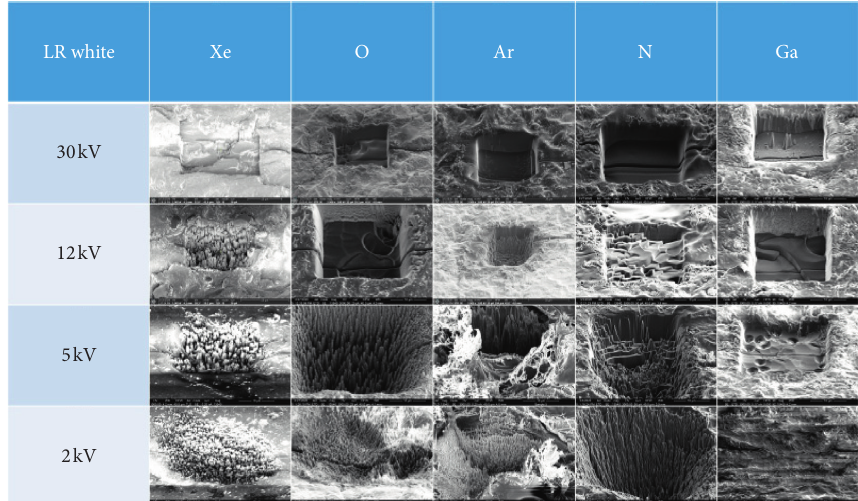
Figure 17: All images of LR White milled with different ion species at varying energies. Area is held constant at 20 µ m 2 . For beam current values, refer Table 1. All images were captured with a horizontal field width of 41.4 µ m. Table 1: All aperture settings used in this experiment.